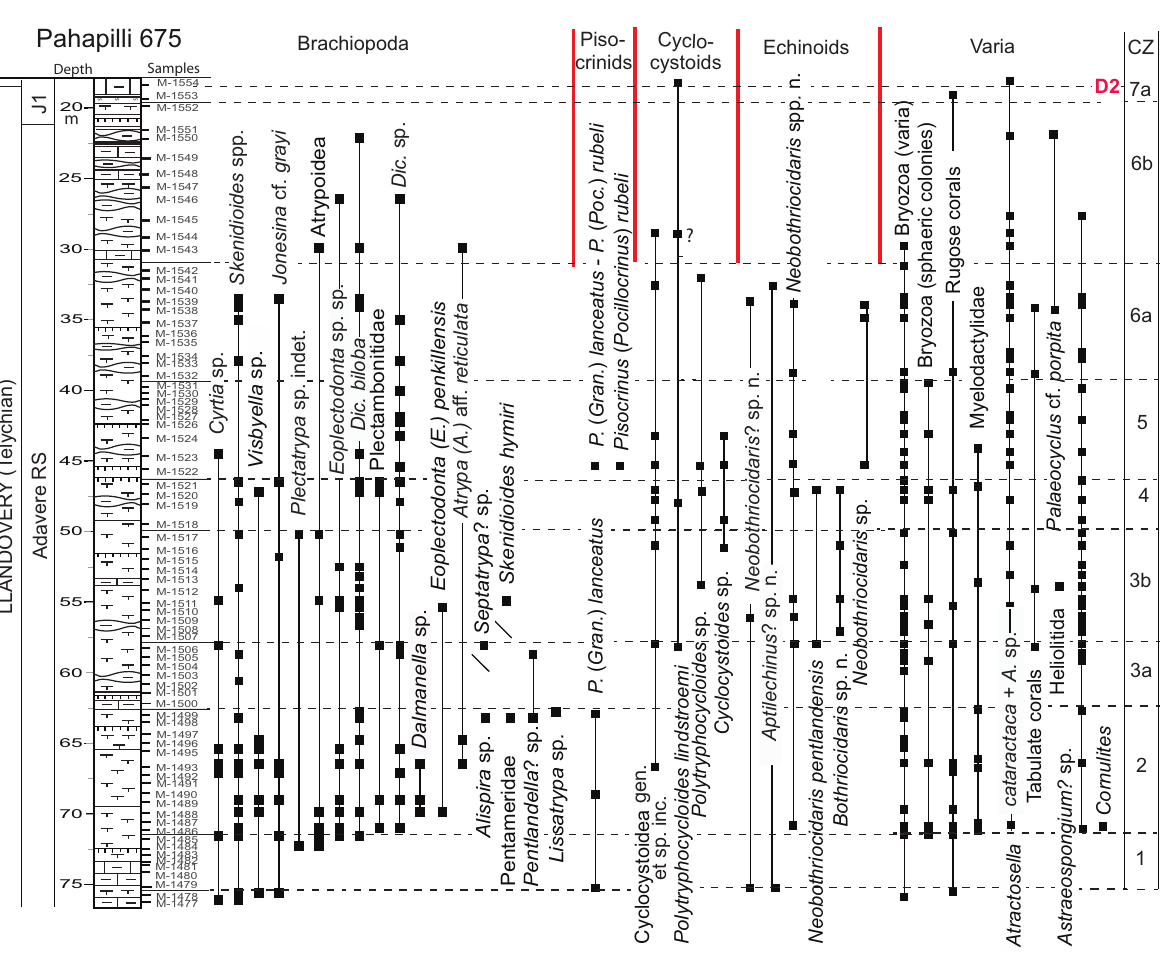
Fig. 4 . Distribution of shelly fossils in the Pahapilli 675 section. For the legend and explanation of indexes, see Figs 2 and 3. J1– Jaani Regional